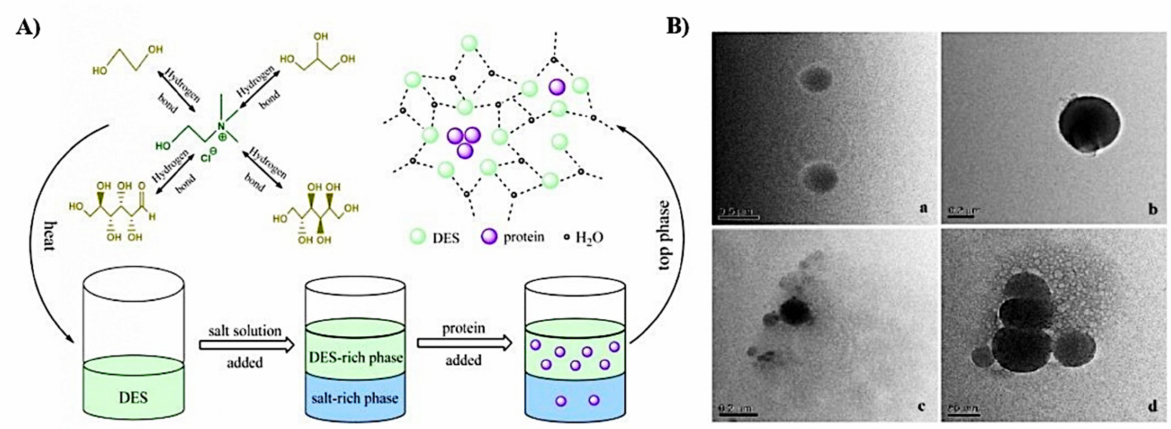
Figure 4. ( A ) Illustration of DES-based ATPS for the extraction of protein. ( B ) The conformation of DES and BSA solution are spherical and it is obvious that DES-proteins aggregates were formed after extraction, shown in TEM images of: ( a ) choline chloride-glycerol DES; ( b ) BSA; ( c , d ) BSA in DES-phase. Reprinted with permission from